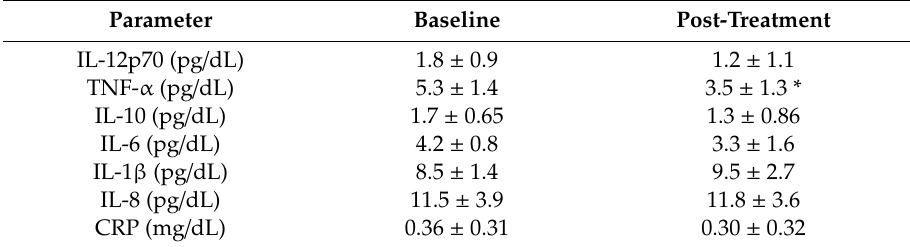
Table 4. Markers of inflammation before and after